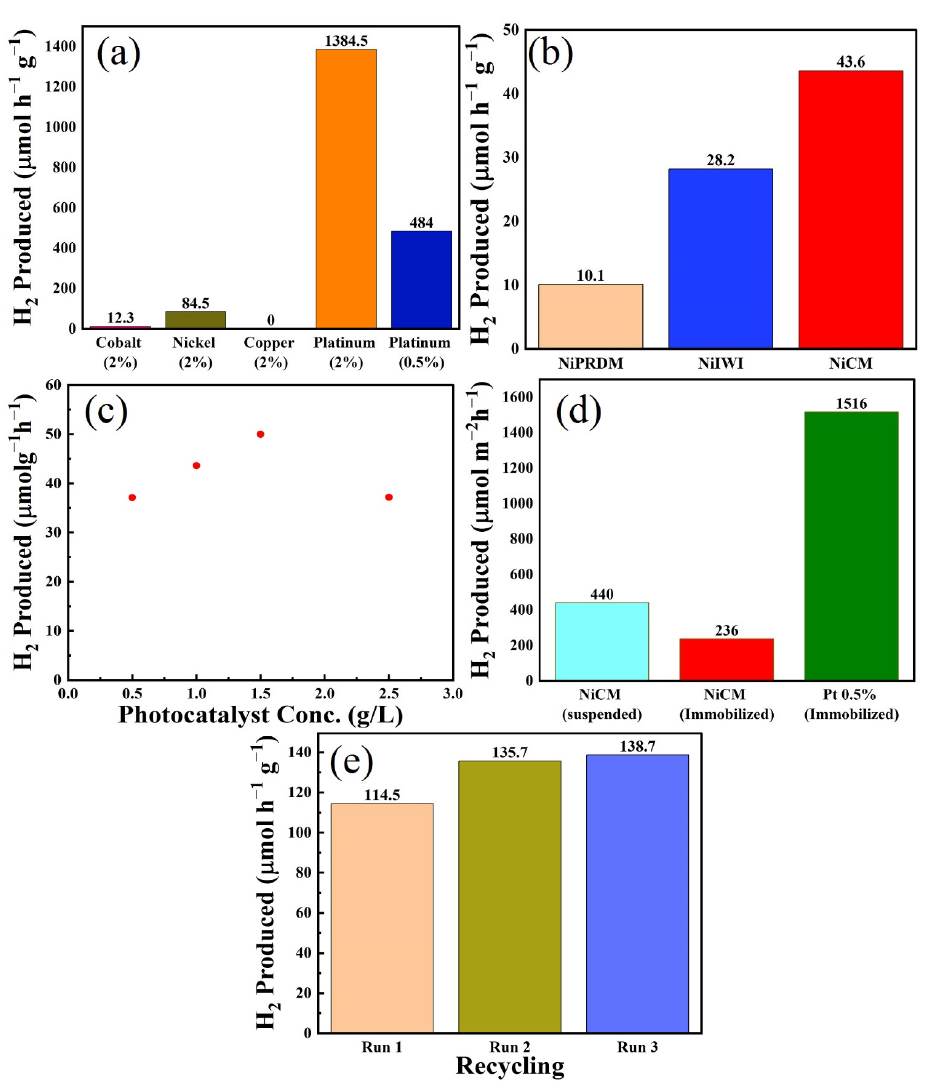
Figure 5. ( a ) Comparison of the photocatalytic H 2 evolution with different noble and non-noble met- als; ( b ) photocatalytic H 2 production activities of different Ni-based samples under visible-light ir- radiation for 6 h; ( c) effect of the catalyst concentration on the hydrogen production; ( d ) photocata- lytic H 2 evolution of suspended and immobilized Ni CM -based photocatalysts and analogous immo- bilized Pt-based photocatalyst; and ( e ) re-utilization of the catalyst (estimated error 10%).